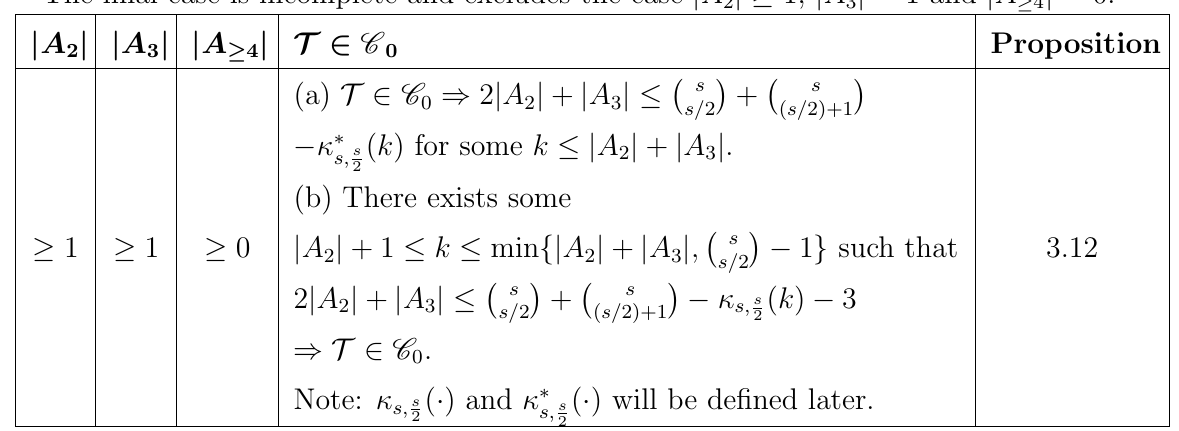
Table 2: Summary for T = T